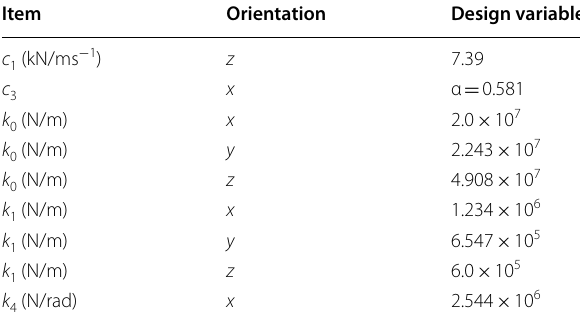
Table 7 Design variable Item